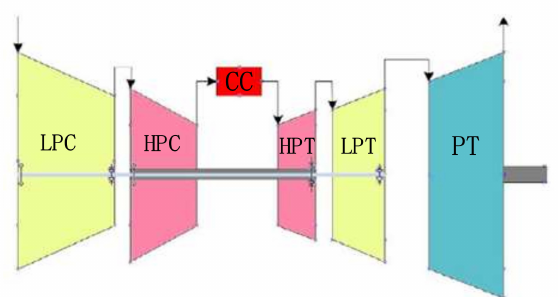
Figure 5. Typical configuration of a three-shaft marine gas turbine.